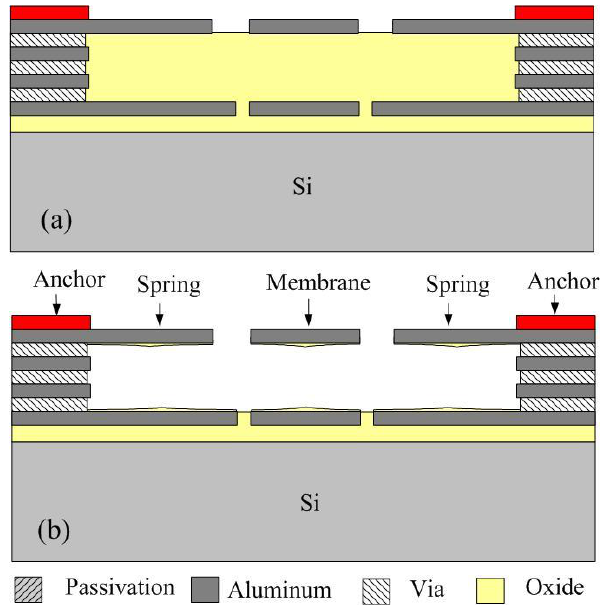
Figure 8. Fabrication flow of the RF switch: ( a ) after the CMOS process; and ( b ) after the